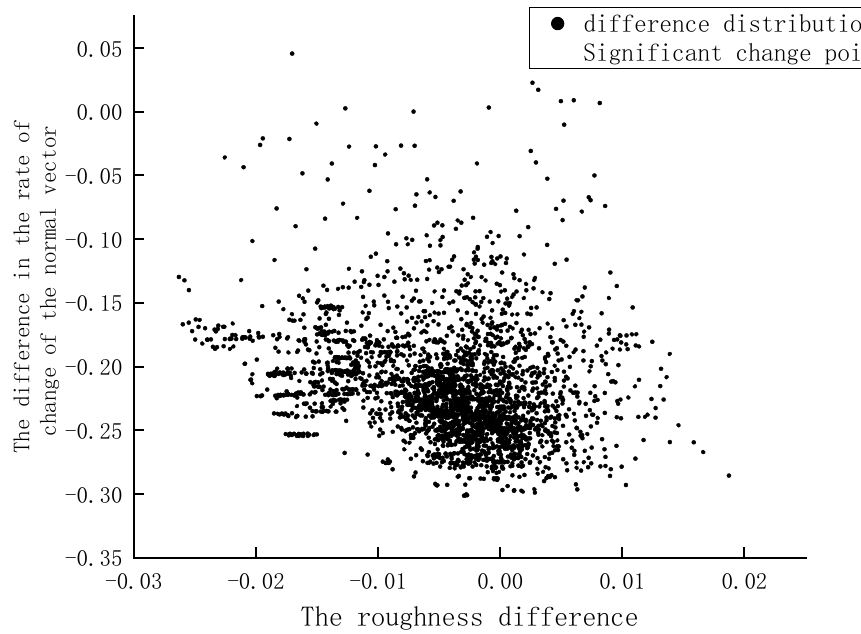
Figure 15. Significant change point characteristic difference distribution.